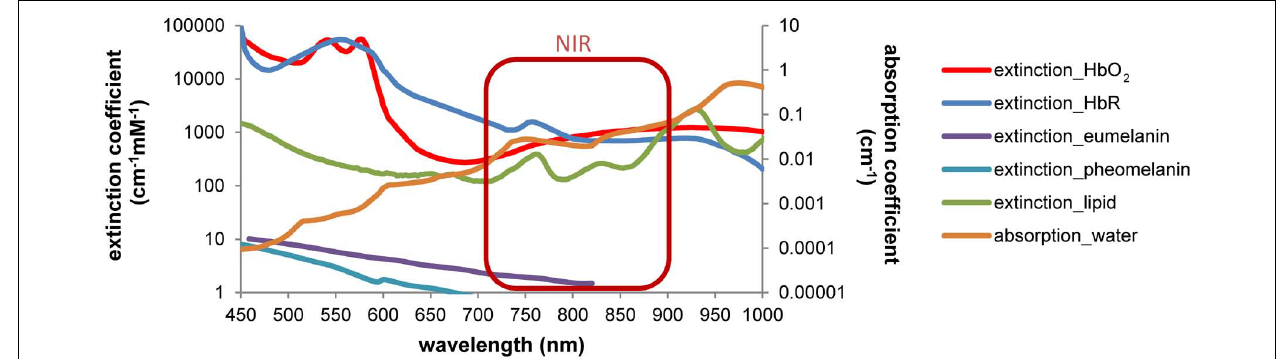
FIGURE 2 |Wavelength-dependent absorption in tissue restricts the optical imaging spectrum. Light absorption by hemoglobin, melanin, lipids and water is wavelength-dependent. Differences can be used to discriminate, e.g., oxy- and deoxyhemoglobin by spectral analysis. A window of low